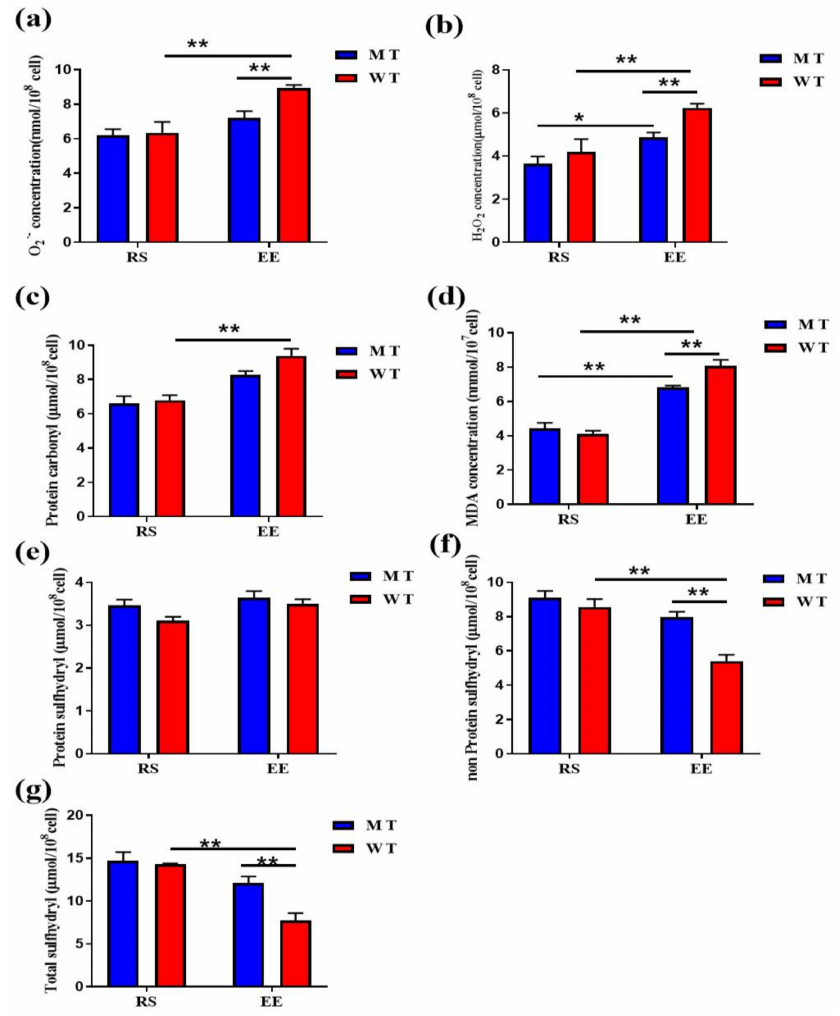
Figure 3. MSTN knockout reduced the oxidative damage of erythrocytes after exhaustive exercise. ( a ) Concentration of O 2 · - in the WT and MT cattle erythrocytes; ( b ) Concentration of H 2 O 2 ; ( c ) Levels of protein carbonyl; ( d ) MDA concentration; ( e ) Protein sulfhydryl; ( f ) Non-protein sulfhydryl; ( g ) Total sulfhydryl state. MT: MSTN knockout cattle group; WT: Wild type cattle group; RS: Resting state; EE: Exhaustive exercise state. Data presented are means ± SD. One-way ANOVA with post hoc LSD multiple-comparison test. * p < 0.05, ** p <